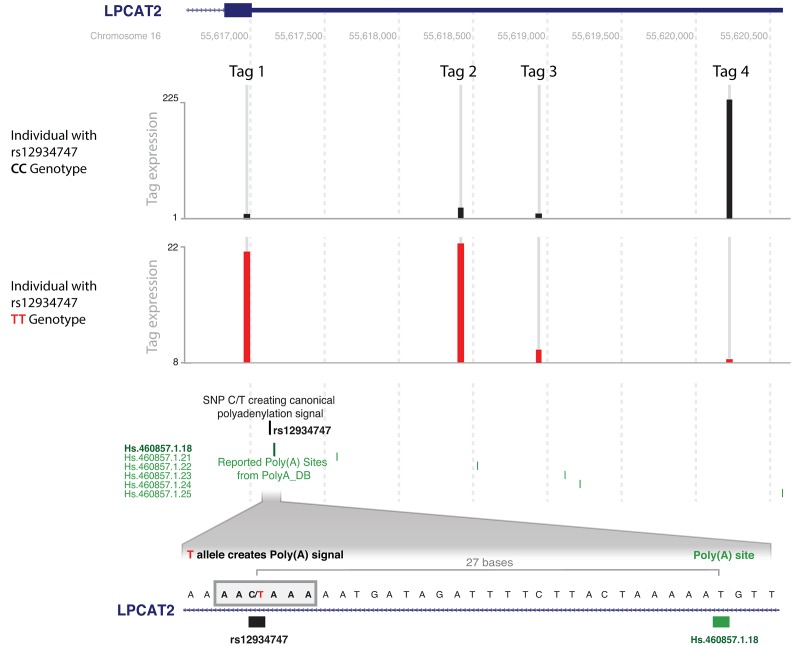
rs12934747*T creates a poly(A) signal in LPCAT2 and leads to alternative polyadenylation site usage.The y-axis represents the number of counts for the deepSAGE tags. Two samples with different genotypes for SNP rs12934747, CC (reference allele) and TT (alternative allele), are shown as different traces. Below the coverage tracks, the position of rs12934747 is shown, together with the position of all reported polyadenylation sites from polyA_DB. An enlargement of the region containing the SNP is shown below. rs12934747 is located at the beginning of the 3′-untranslated region (3′-UTR) of LPCAT2, 27 nucleotides upstream a reported and experimentally validated polyadenylation site. This SNP changes the sequence, creating a polyadenylation signal that leads to the usage of the reported polyadenylation site. The square block indicates the sequence of the polyadenylation signal created by rs12934747. The creation of this signal shortens the 3′-UTR, as indicated by the higher abundance of the proximal DeepSAGE just upstream of the polyadenylation signal, and the nearly absent distal DeepSAGE, in the sample with the TT genotype (both tags indicated by arrows). Tag 2 was filtered out because it was expressed in less than 90% of individuals. There is an additional tag 3 in-between the proximal and distal tags, which is not cis-regulated.